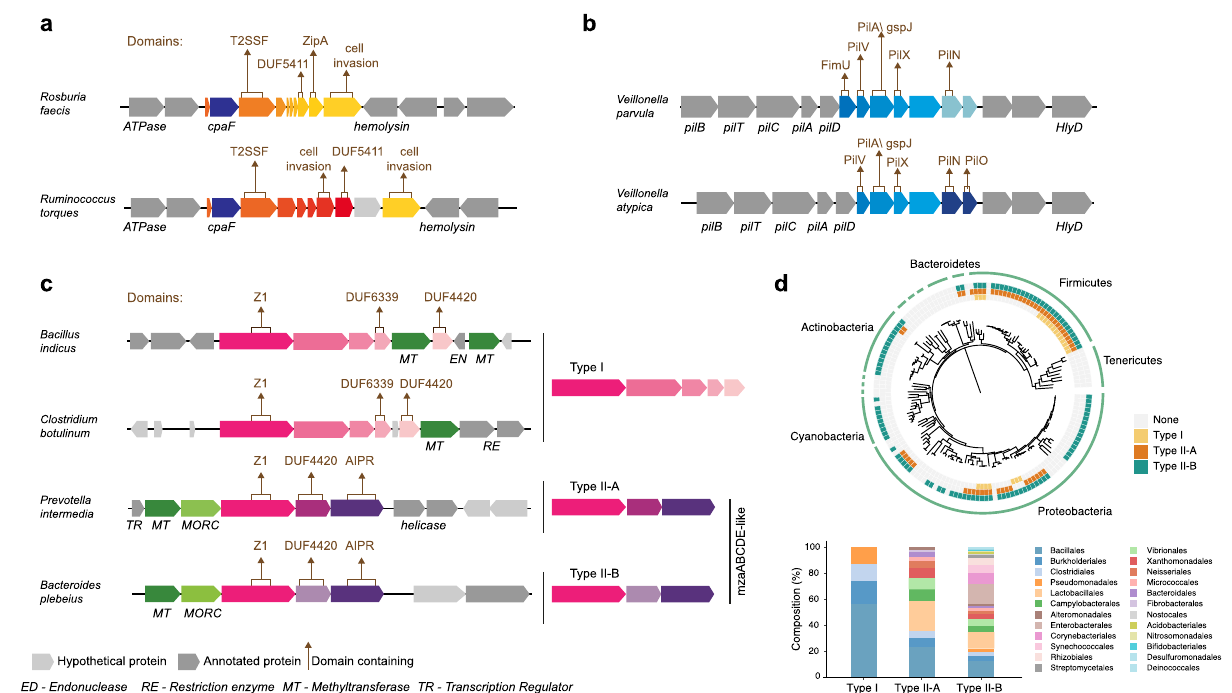
Fig. 5 | Predicted systems. For all gene operons, known annotations are denoted below the gene illustration, and domains of unannotated genes are marked with arrows above the gene. a Predicted secretion-related operons abundant in three Clostridiumgenera.Thegenesthatwerepredictedbyourapproacharemarkedby the yellow/orangegradient coloring. b A distant variant of thetype IV pilus system intworepresentativesofthe Veillonella genus.Thegenespredictedbyourmethod